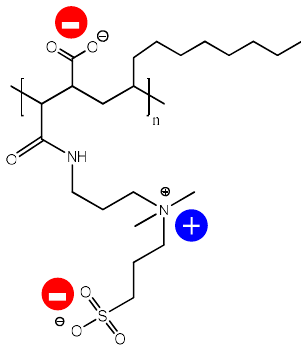
Figure 9. Charges distribution in ZW polymer used for PVDF modification.